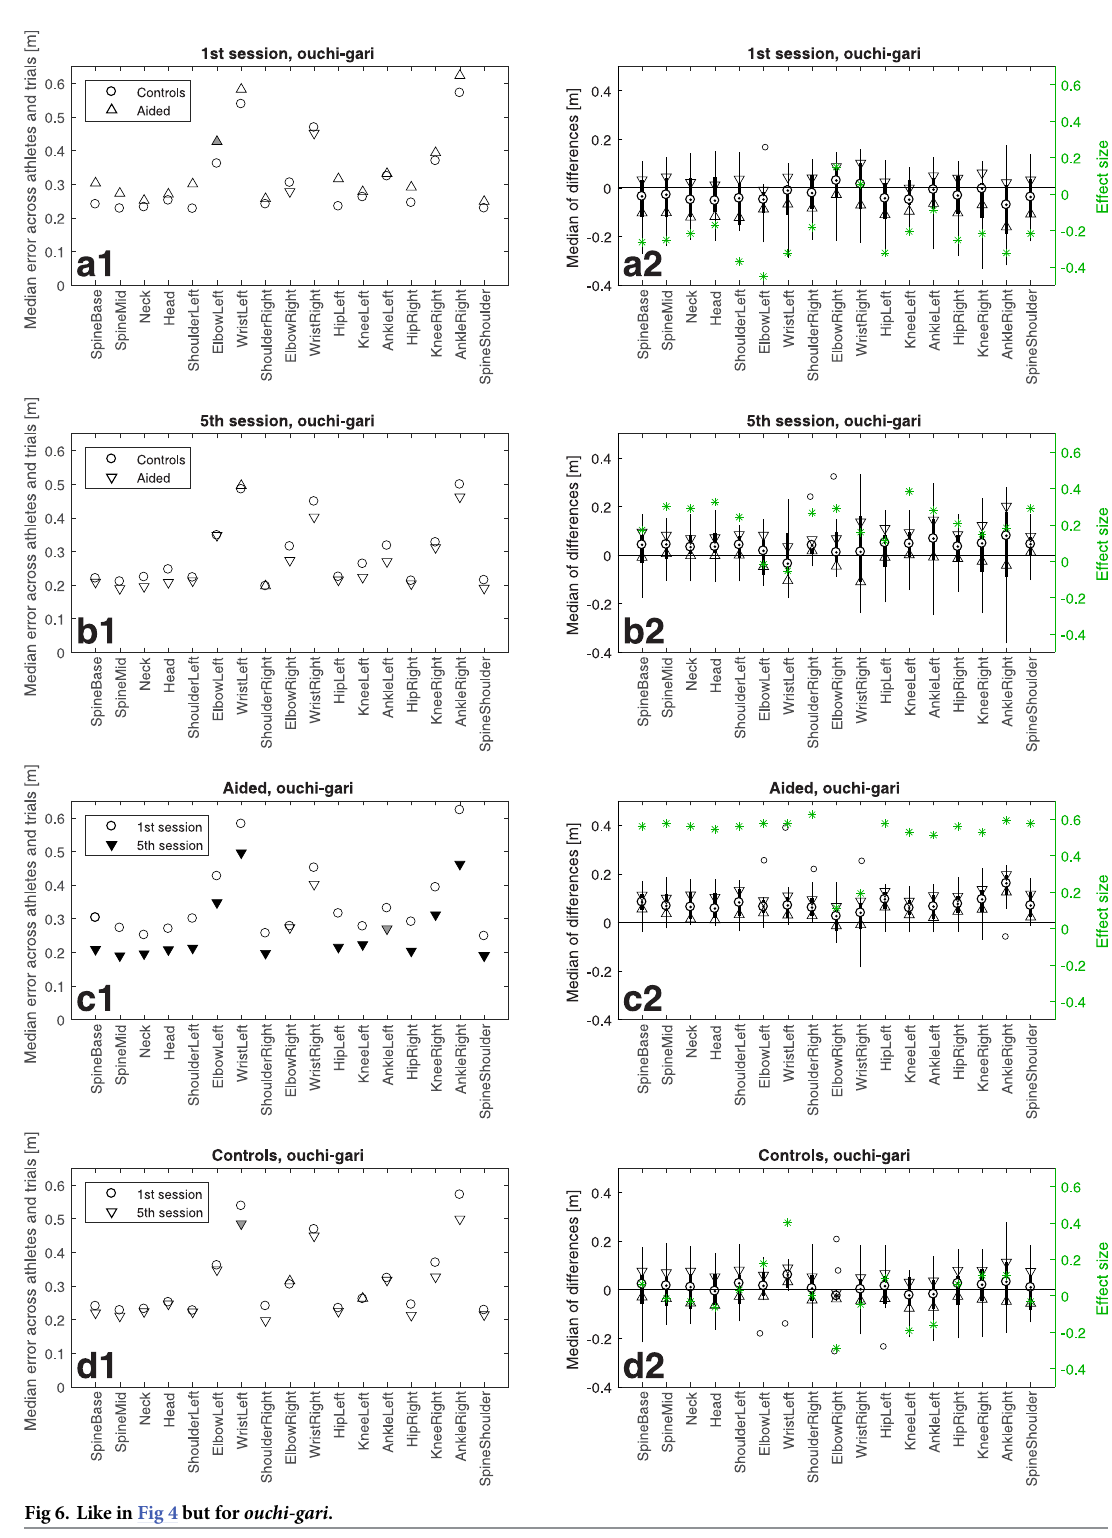
Fig 6. Like in Fig 4 but for ouchi-gari .